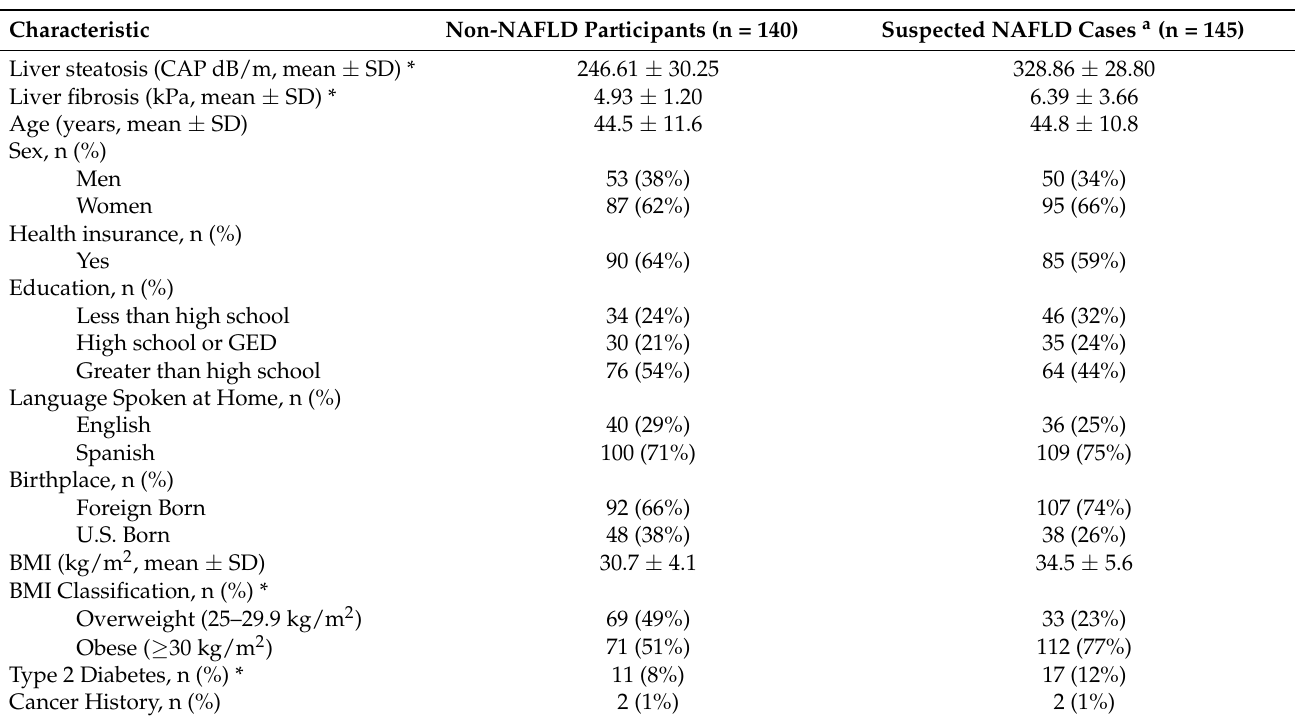
Table 1. Demographic and clinical characteristics of a Mexican-origin Hispanic sample from Southern Arizona by suspected NAFLD status (N = 285).